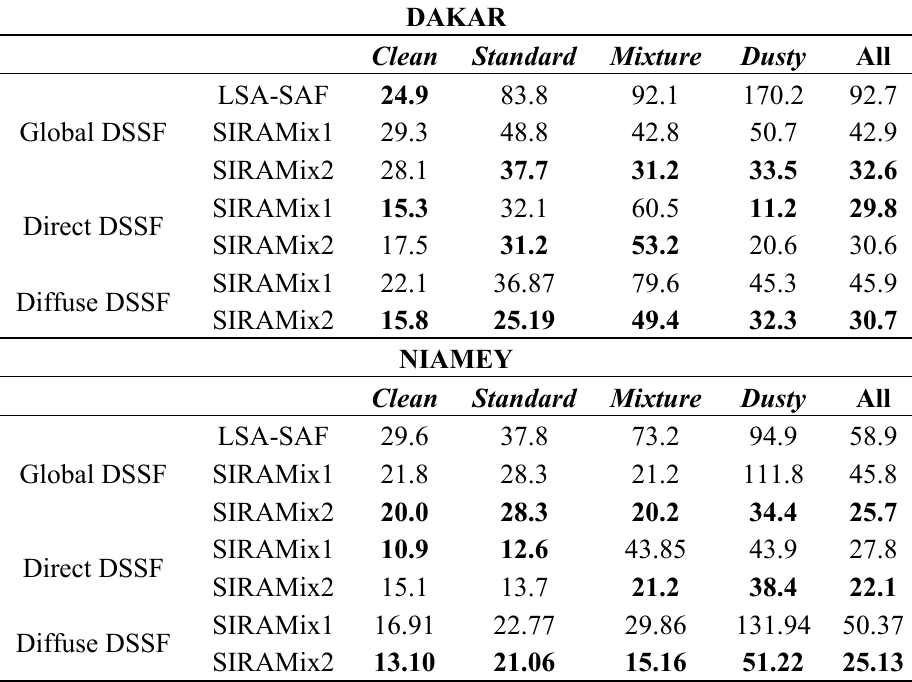
Table 6. RMSE in W/m 2 of the global, direct and diffuse DSSF estimated by the different retrieval methods (LSA-SAF, SIRAMix1 and SIRAMix2) in Dakar and Niamey. Average values of RMSE are given per day type ( i.e. , clean , standard , mixture , dusty ) and for all selected days combined (column “All”). Bold values indicate the lowest RMSE values in each